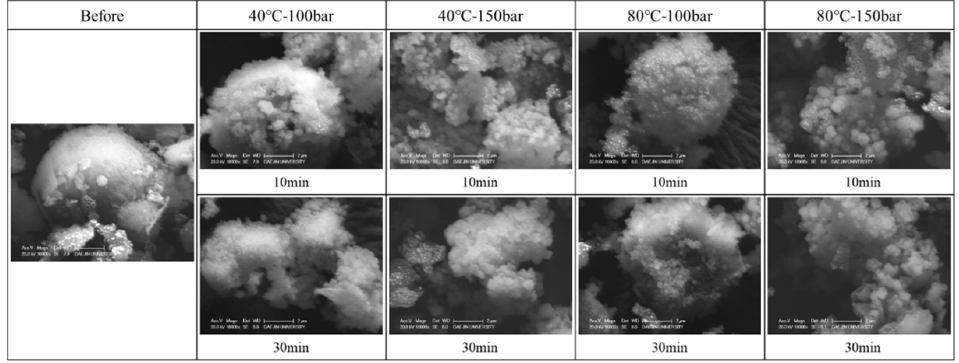
Figure 6. SEM characterization results.